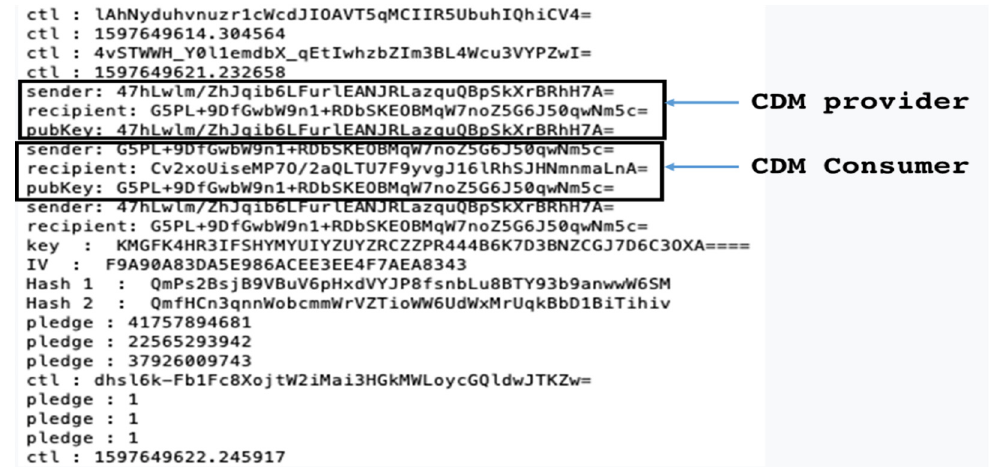
Figure 8. The transaction log having a note CDM for registering public keys in SC-Blockchain.